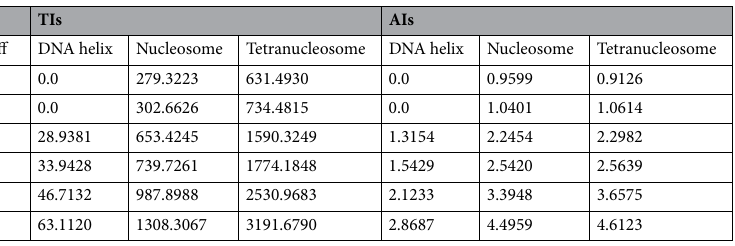
Table 1. HodgeRank-based analysis of DNA folding at atomic level. There different DNA structures, including DNA helix (ID: 330D), nucleosome (ID: 6KVD) and tetranucleosome (ID:1ZBB), are considered. The simplicial complexes are generated using a series of different cutoff distances including, 10 Å, 12 Å, 14 Å, 16 Å, 18 Å and 20 Å.